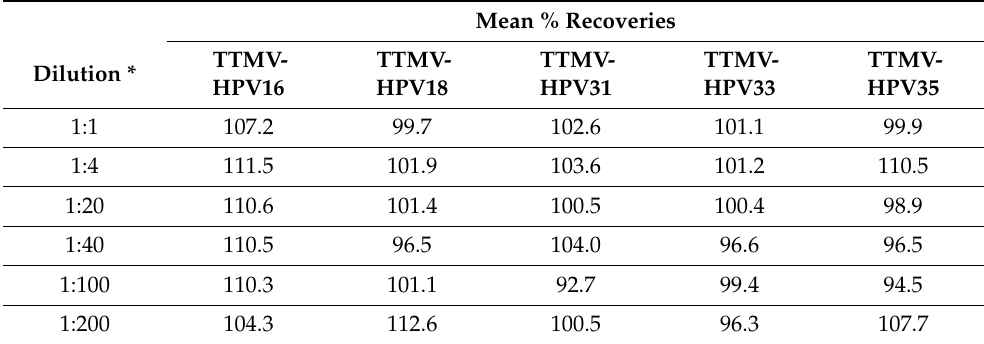
Table 3. Analytical accuracy expressed as mean percent recoveries for TTMV-HPV DNA types over a range of dilutions with prepared HPV samples.